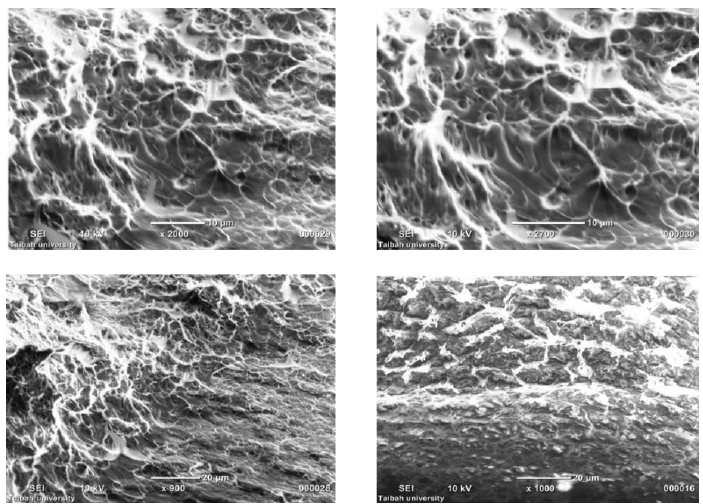
Figure 4. SEM of polynorbornene pendent spiropyran 9 . (After plasma treatment for 2 min ( top ) and 5 min ( bottom )).